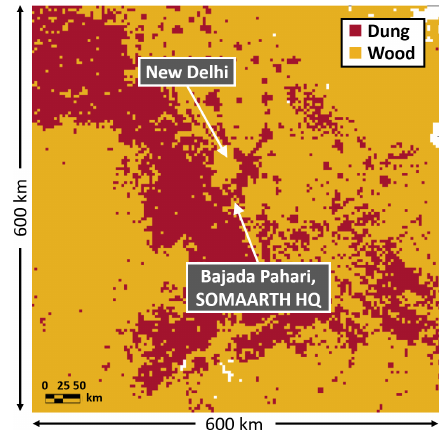
Figure 3. Fuel type assumed for speciation of household NMHC emissions. Study domain: 600km by 600km at 4km resolution. Red indicates cells where dung use dominated emissions and thus was assumed to be the sole fuel type used. Orange indicates cells where wood and agricultural residue use dominated emissions and was thus assumed to be the sole fuel type